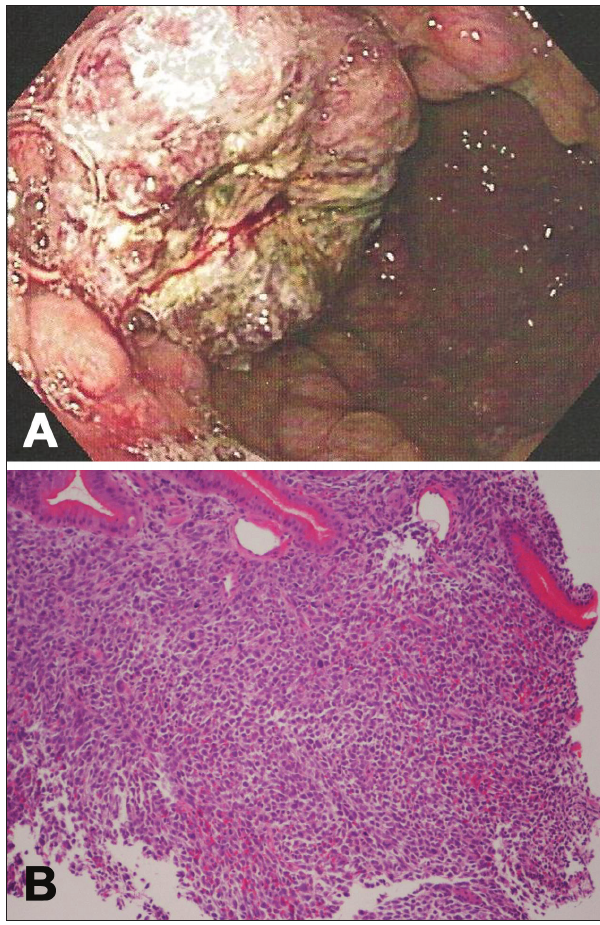
Figure 2) A Endoscopic view of polypoid ulcerated gastric neoplasm. B Pathological confirmation of undifferentiated malignant cells, focally spindled and focally epithelioid. Immunostains (see text) for stromal tumour, smooth muscle or neuroendocrine lesions negative (hematoxylin and eosin stain, original magnification